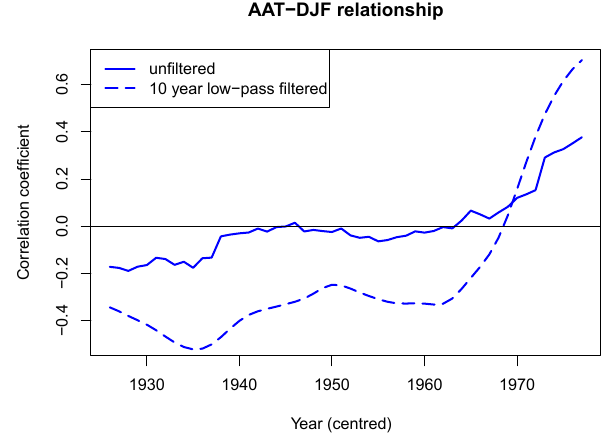
Fig. 9. Running correlation of AAT and DJF temperature. The length of the time window is 50 years. Solid line: unfiltered data; dashed line: decadal time scale (data low-pass filtered prior to the correlation using a 1/10 year cutoff). The p =0.05 significance level is at ρ = ± 0.28 (unfiltered data) and at ρ = ± 0.6 (filtered